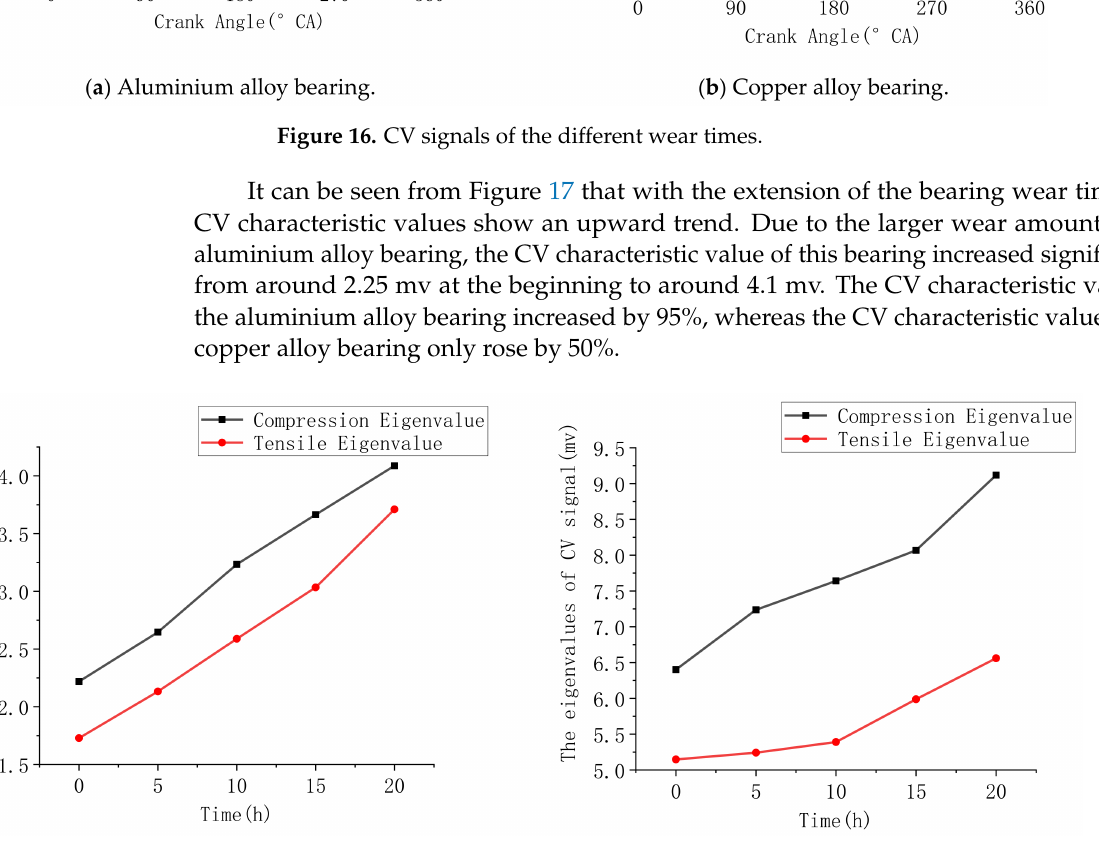
Figure 17. Comparison of CV characteristic values of different wear test